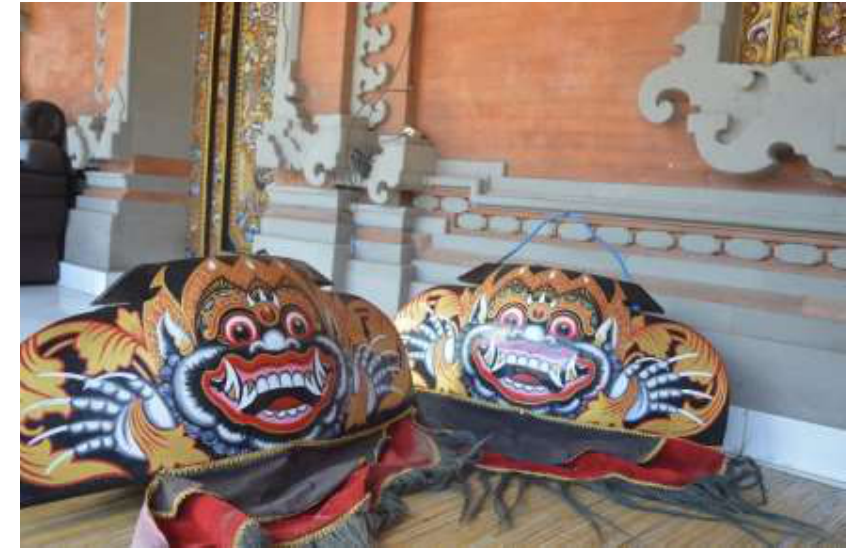
Figure 3. One of Okokan Instrument